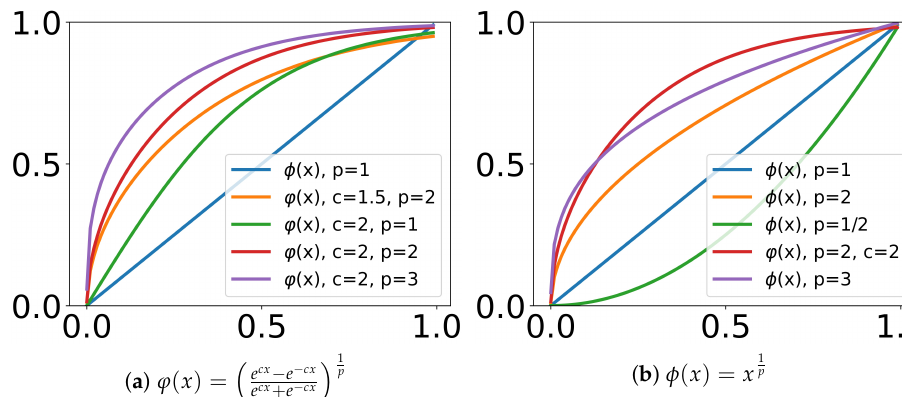
Figure 2. Plots of two transformation functions.